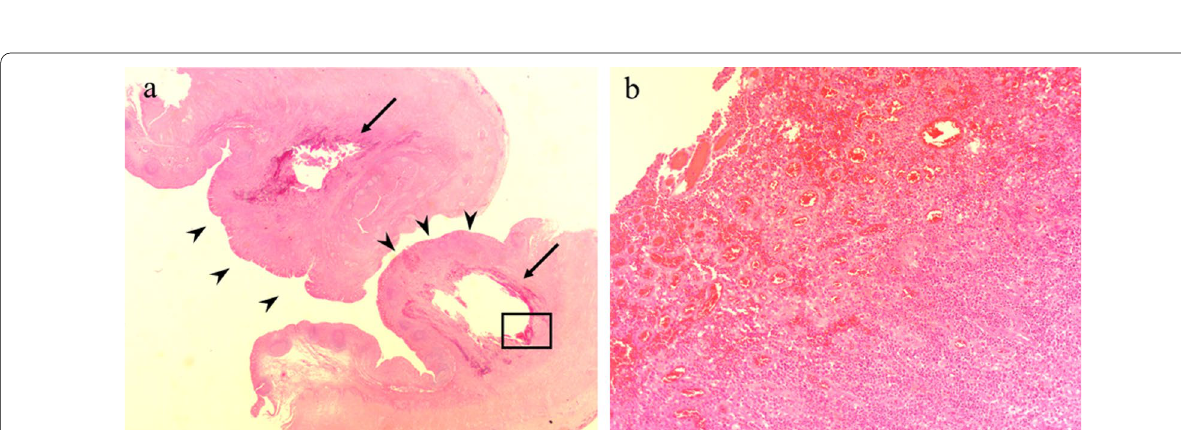
40.) b An enlarged image with a square on a. No ×